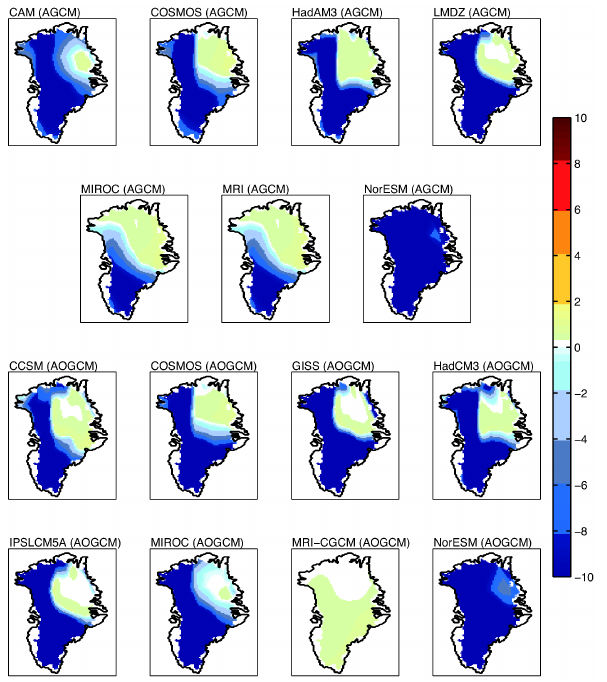
Figure 8. BASISM Surface Mass Balance (SMB;m yr − 1 ) pre- dictions for the mPWP (on the ISM grid) derived from the PlioMIP climatologies and using standard glaciological parameters ( ∝ i = 8mmday − 1 ◦ C − 1 and ∝ s = 3mmday − 1 ◦ C − 1 , lapse rate = − 6 ◦ Ckm − 1 ) . The SMB is plotted for the first time step (prior to a lapse rate correction) and shows areas of ablation (negative SMB) and accumulation (positive SMB) based on the temperature and pre- cipitation fields shown in Figs. 2–4.